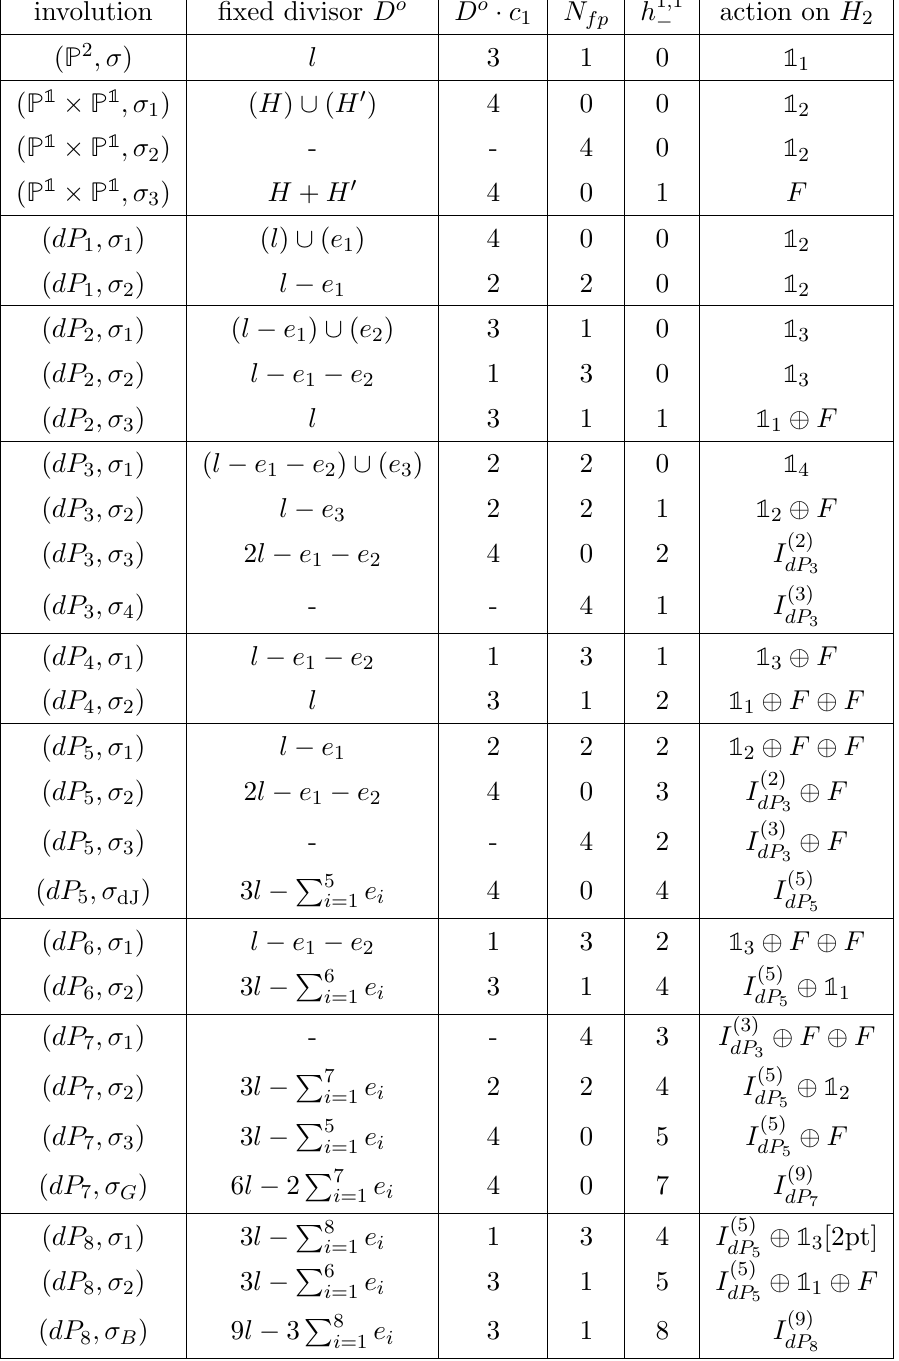
Table 3 . Table adopted from table 6 of [17]: the possible Z 2 involutions of del Pezzo surfaces, the (cid:12)xed divisor D o , its intersection with the anti-canonical divisor D o 1 points N fp , the values of h 1 ; 1 , and actions on the divisor classes ( l; e 1 ; : : : ; e n ) respectively ( H; H 0 ). (cid:0) F denotes a (cid:13)ip e